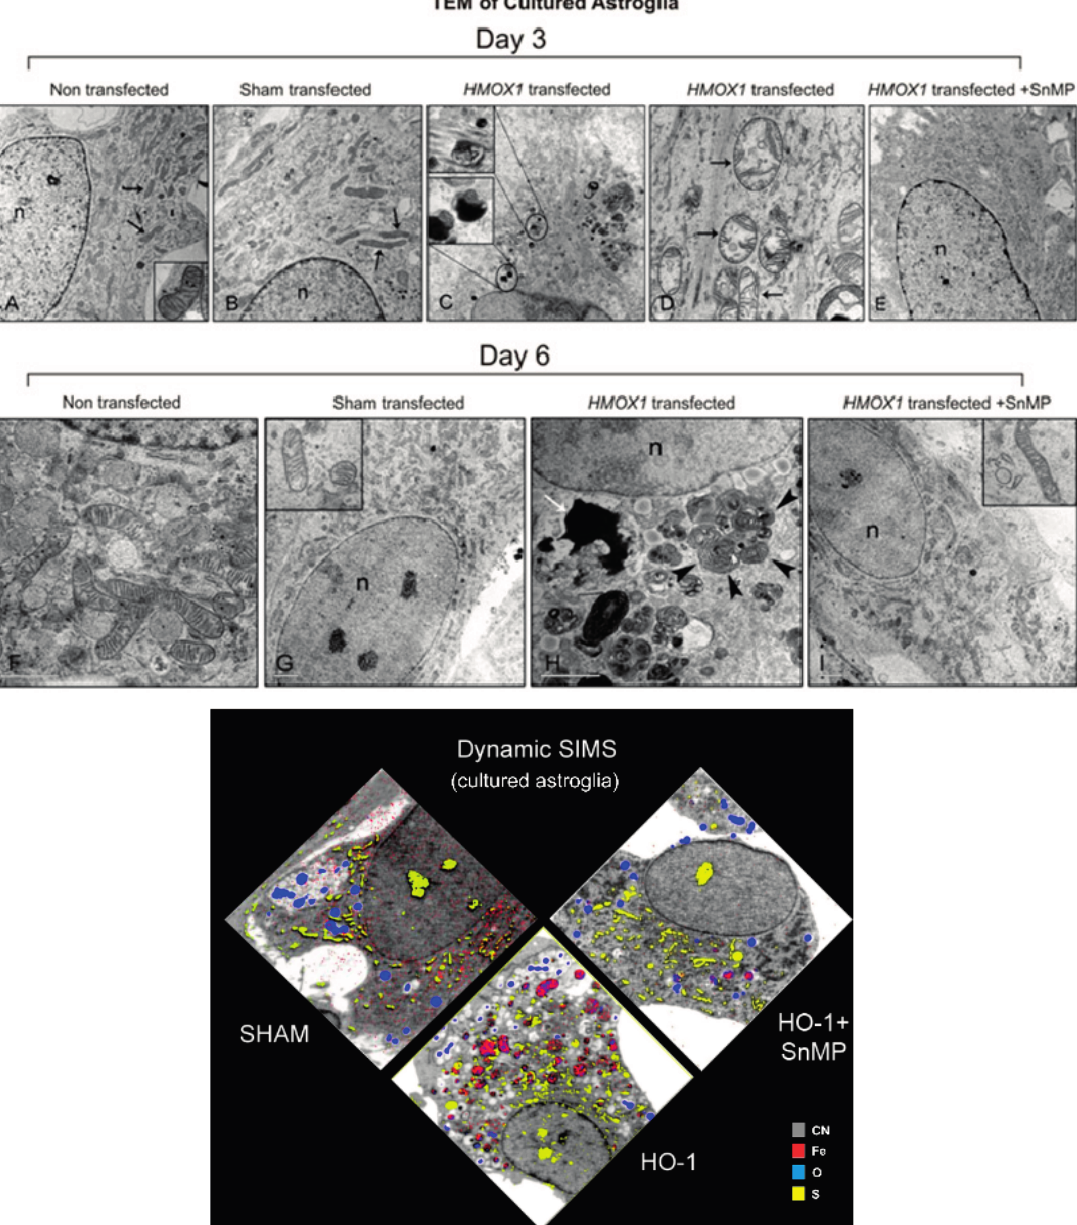
Figure 3. Effects of HMOX1 transfection on astrocyte ultrastructure and iron deposition. HMOX1 -transfected cells ( C , D , H ) contain degenerate mitochondria (straight black arrows), cytoplasmic autophagic and multilamellar bodies ( C inset, arrowheads) and lipofuscin-like material (white arrow). These pathological profiles are not seen in non-transfected ( A , F ) and sham-transfected ( B , G ) cells or in HMOX1 -transfected cells treated with the HO inhibitor, SnMP ( E , I ). ( J ) Dynamic secondary ion mass spectroscopy (SIMS) of sham-transfected astrocytes, HMOX1 -transfected cells (HO-1) and HMOX1 -transfected cells exposed to SnMP (HO-1 + SnMP). Ions of interest (colored) are superimposed on cytoarchitecture (grey-scale) visualized by CN mapping. Note robust iron deposition (red) in HMOX1 -transfected cells, an effect that is abrogated by exposure to SnMP. Magnification bars = 2 μ m in panels A – C , E & G – I , and 1 μ m in panels D & F . SnMP = tin mesoporphyrin. (Modified from [49], with